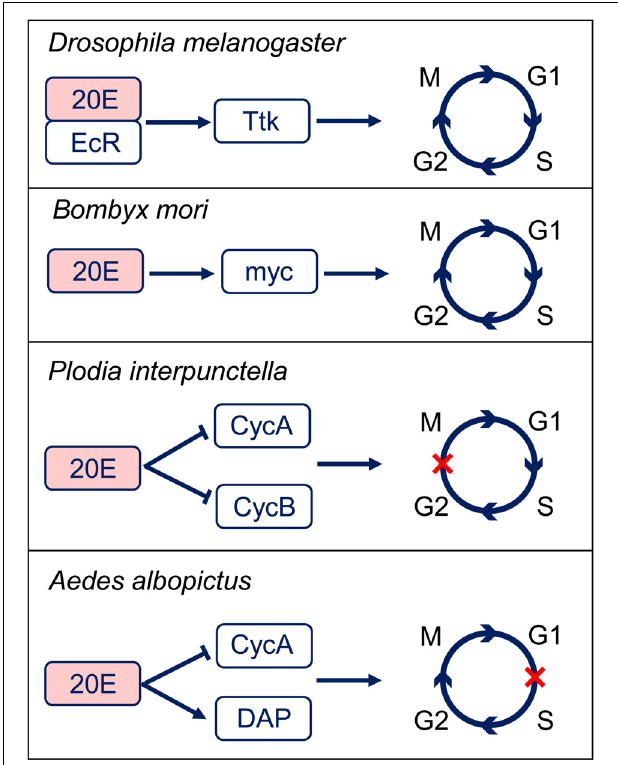
FIGURE 3 | 20-hydroxyecdysone (20E) regulation of the cell cycle progression. In Drosophila melanogaster , 20E-EcR positively regulates Tramtrack (Ttk) to transit the endocycle to mitotic cycle. In Bombyx mori , 20E promotes cell cycle progression through activation of c-Myc. In Plodia interpunctella , 20E induces an arrest of cells in G2 phase by decreasing the expressions of cyclin (Cyc) A and B. In Aedes albopictus , 20E application results in an accumulation of cells in G1 phase by decreasing CycA and increasing Dacapo (DAP) expresisons. EcR, ecdysone